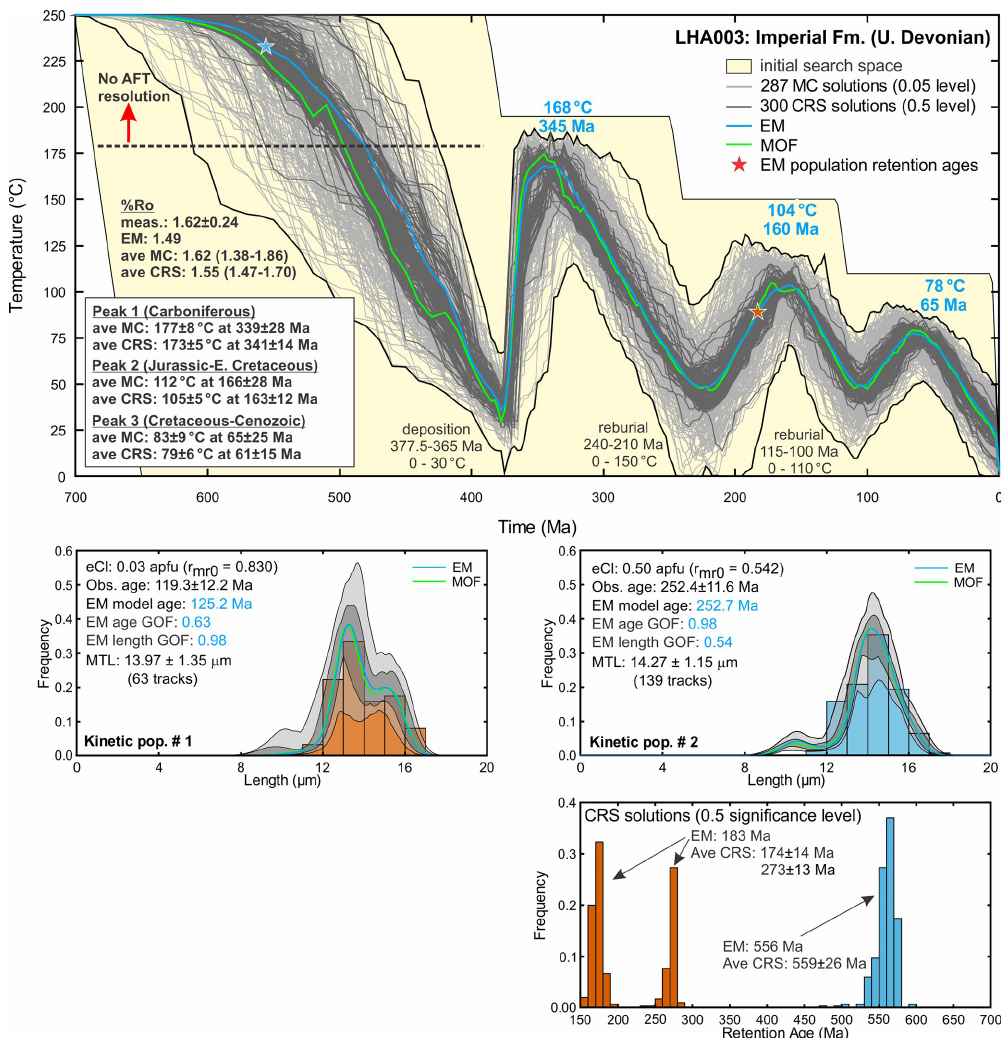
Figure 7. The upper panel shows AFTINV thermal-history results for the Devonian sample. Light grey lines are statistically acceptable Monte Carlo solutions ( ≥ 0 . 05 significance level), and dark grey lines are good solutions ( ≥ 0 . 5 level). The black curves bounding model solutions are not valid solutions. The blue curve is the exponential mean (EM) of the 300 good solutions, and the green curve is the closest fitting minimum objective function (MOF) solution. The lower panels show model and observed track length distributions and the distribution of model retention ages (age of oldest track) for the different kinetic populations. The goodness of fit (GOF) probability for the age and length data is given for the exponential mean solution. Uncertainties in average retention age, average peak temperature, and average peak time are 2 standard